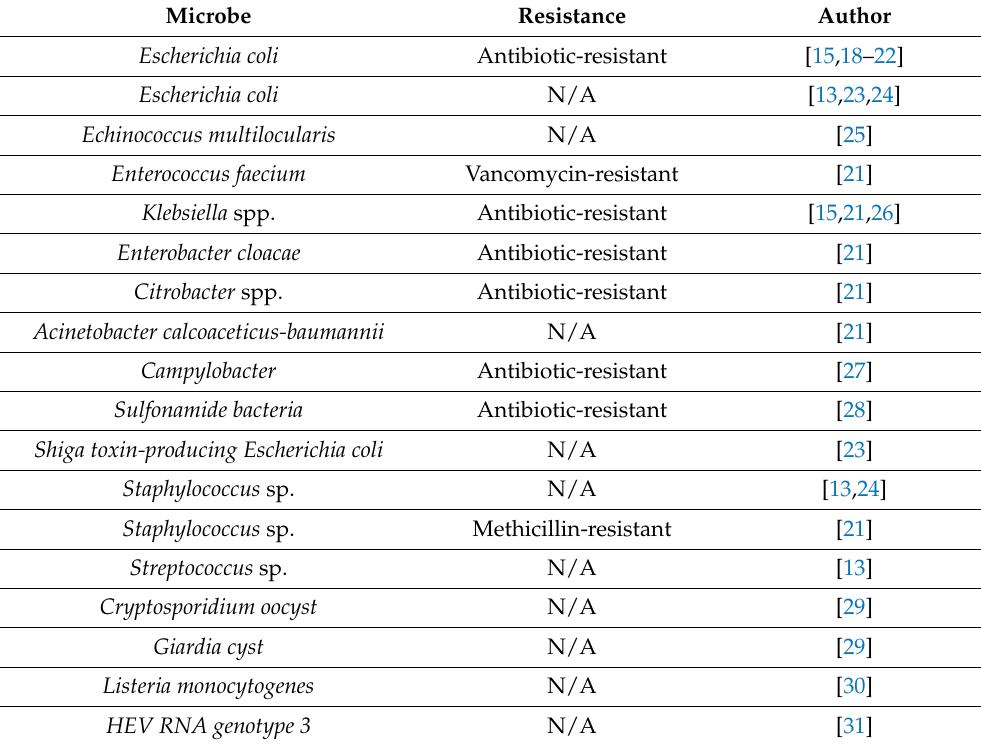
Table 1. Microbial characterization studies in slaughterhouse wastewater from